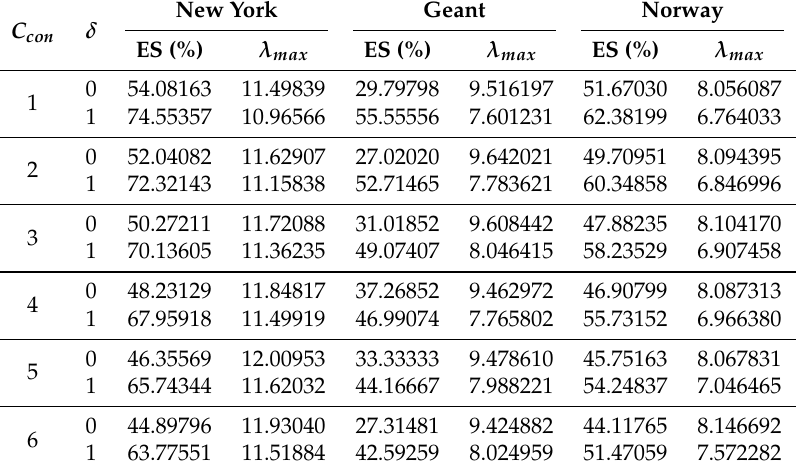
Table 5. Average performance under connectivity and resilience constraints. ES, Energy